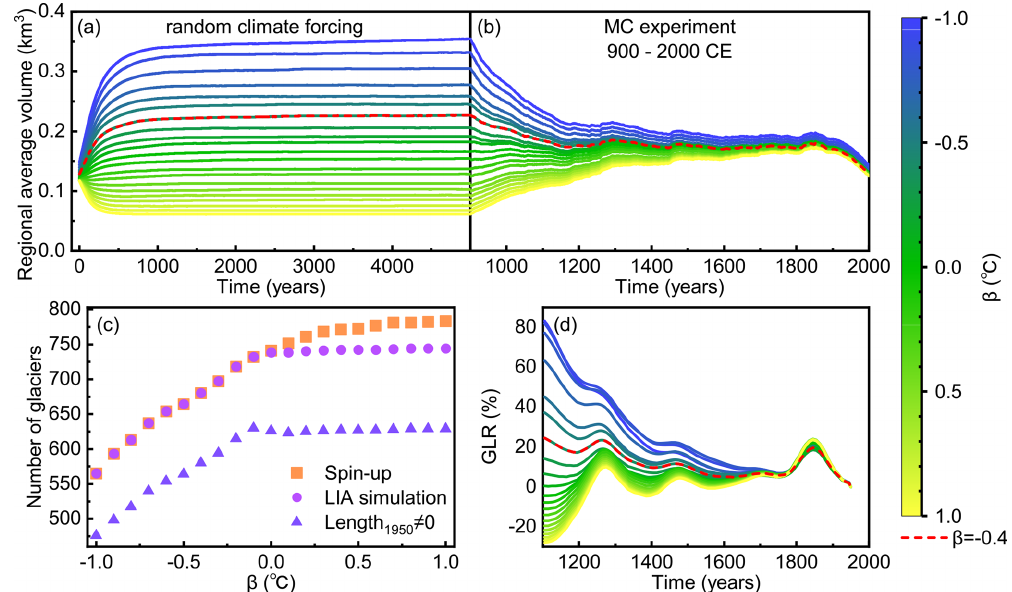
Figure 2. (a) The regional average glacier volume during the 5000-year spinup with various β . (b) The simulated regional average glacier volume from 900 to 2000CE with different post-spinup conditions. (c) The number of available glaciers with various β . (d) The simulated regional average GLR from 1100 to